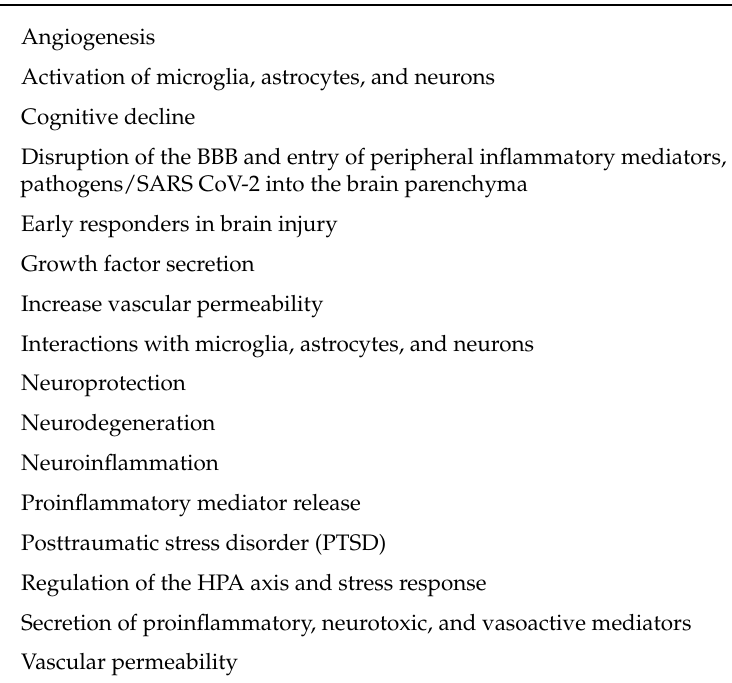
Table 1. Mast cell actions associated with brain